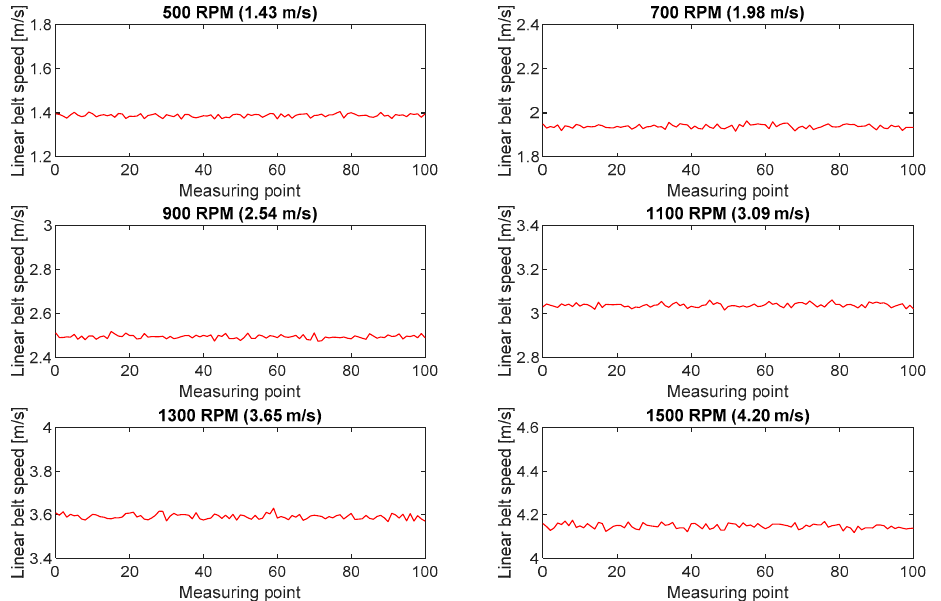
Figure 5. Series of belt linear speeds calculated in the measurements with the use of the incremental encoder for six rpm ranges of the pulley motor.